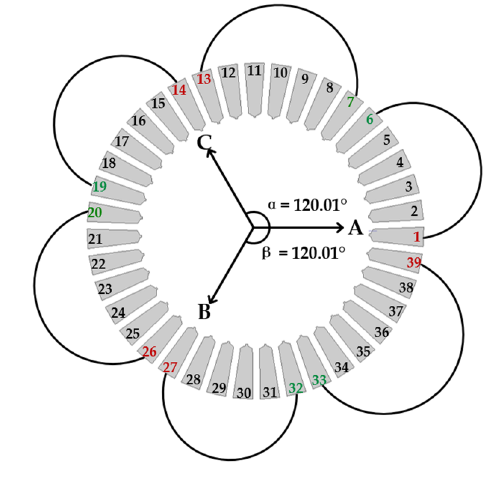
( b ) Figure 14. Torque waveforms of two motors: ( a ) 39 − slot and 6 − pole motor of UBW; ( b ) single − layer 39 − slot and 6 − pole motor.